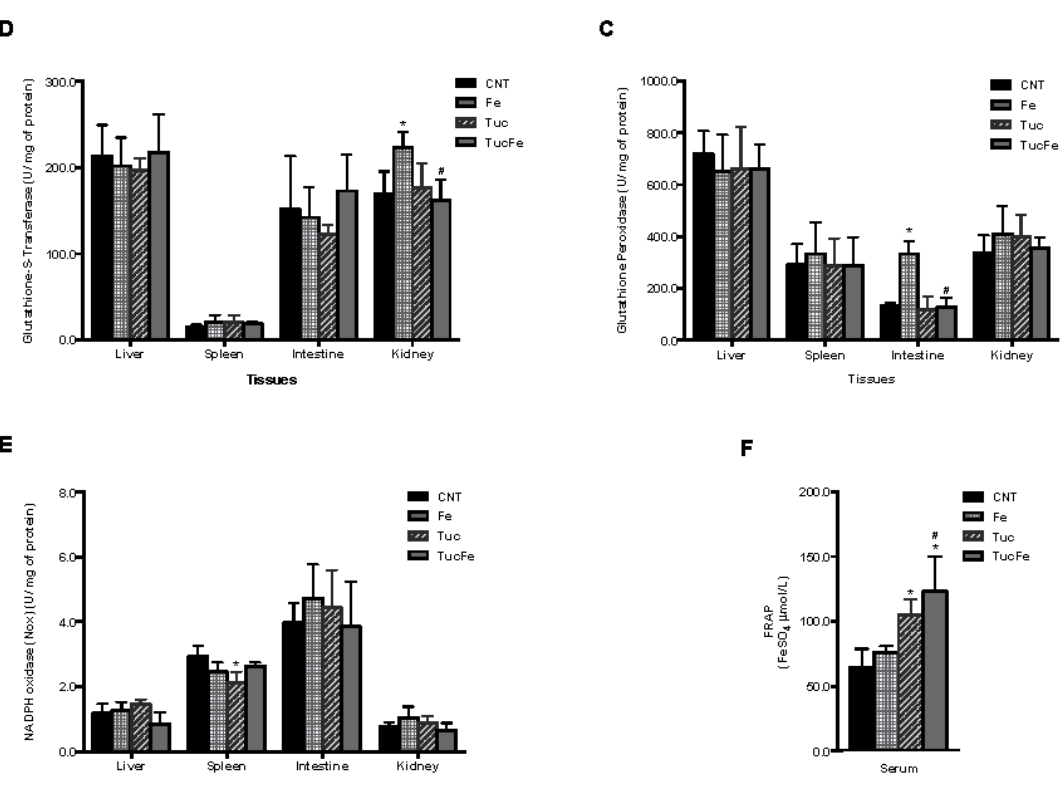
Figure 3. Specific activity of catalase ( A ); glutathione reductase ( B ); glutathione peroxidase ( C ); glutathione-S-transferase ( D ); NADPH oxidase ( E ) in tissues homogenates, and serum antioxidant capacity ( F ), according to group treatment. CNT, Control group; Fe, iron-enriched group, Tuc, tucum-do-cerrado group; TucFe, tucum-do-cerrado iron-enriched group. Data are the means ± SD ( n = 6). Significant differences ( p < 0.05): * Comparison to the Control group; # Comparison to the Fe group.